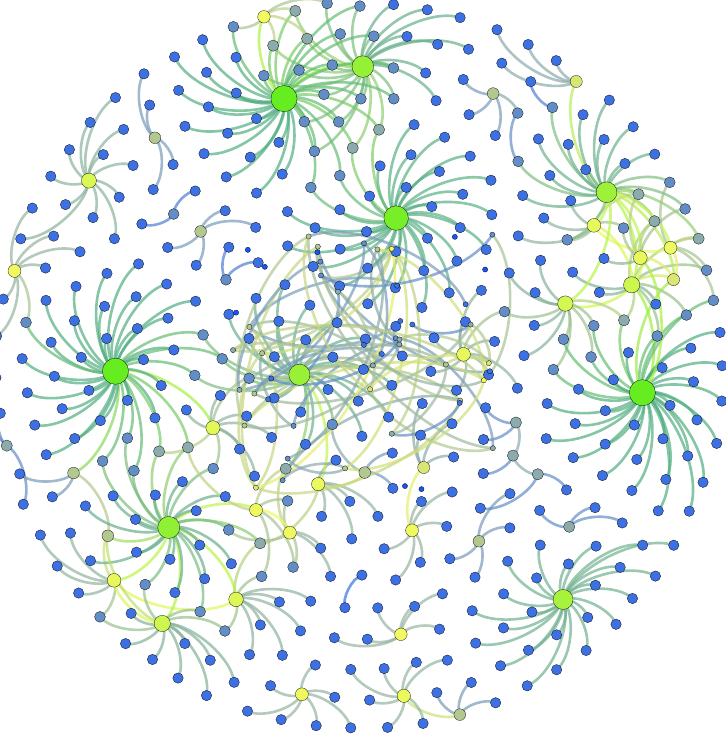
Figure 3. Characterizing citation relationships of article-article networks. The degrees of nodes range from small (blue) to large (green). The larger the degree of a node is, the more references the article